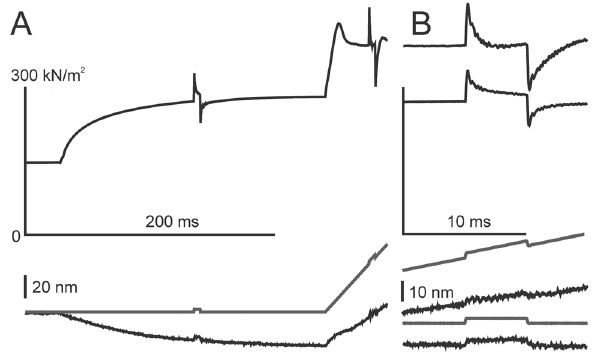
Figure 2. Change in instantaneous stiffness measured in a control experiment with a single muscle fiber. A : records from top to bottom: tension, change in half-sarcomere length, D SL, calculated from the motor position for SL=2.45 m m; D SL measured by laser diffraction (more noisy traces). B : two fragments of the records shown in A on an expanded time scale to visualize changes in tension and sarcomere length during and after the step length changes applied during isometric contraction and ramp stretch. The length changes were used to measure fiber stiffness.